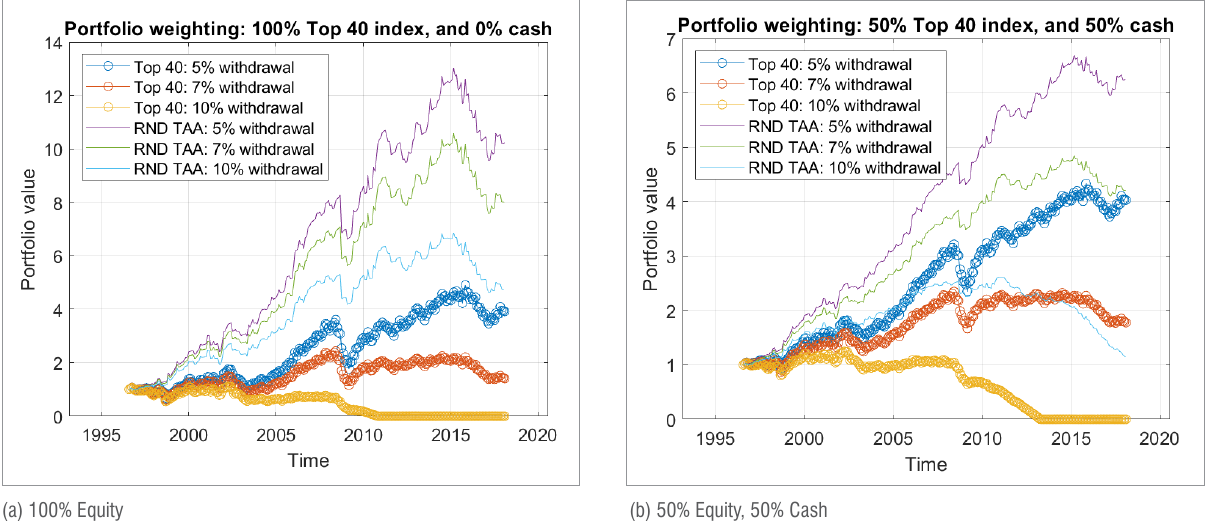
The accumulated portfolio value for a fixed asset allocation vs the risk-neutral tactical asset allocation (RND TAA) framework with withdrawal rates of {5%, 7%, 10%} returns.